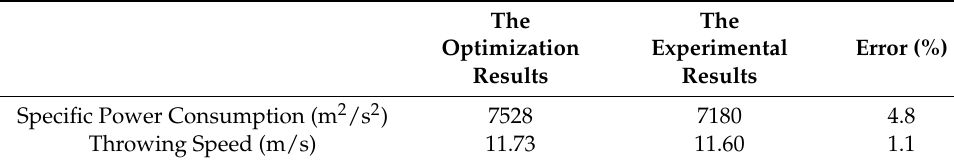
Table 7. The relationship among the specific power consumption, the rotate speed of throwing impeller, feeding quantity and sectional area of throwing pipeline.